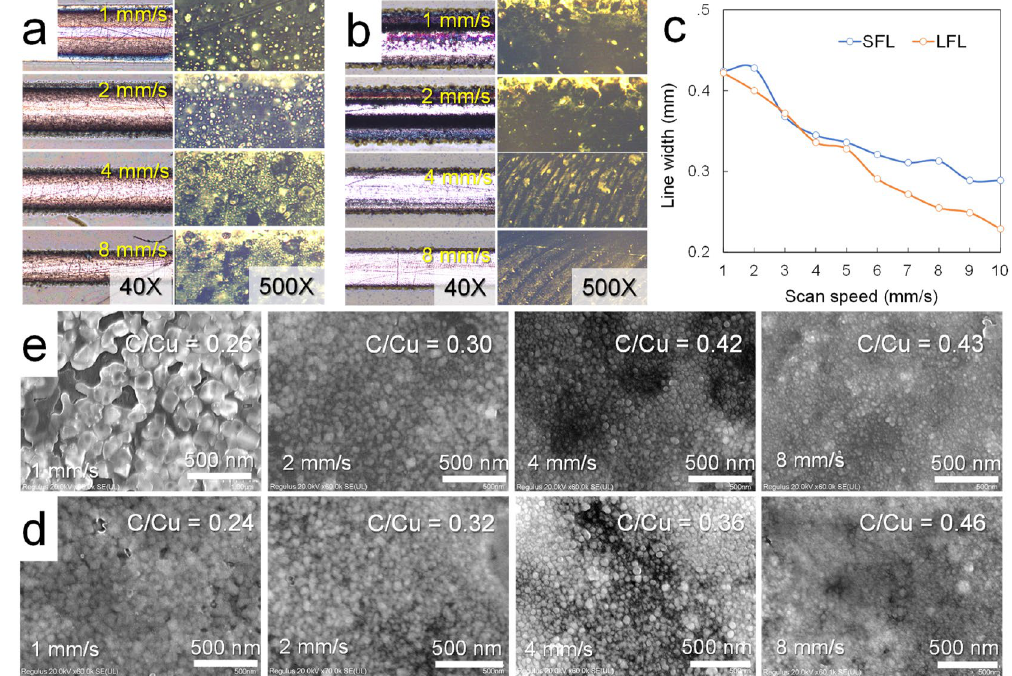
Figure 5. Microscope and scanning electron microscope (SEM) images of patterned Cu as a function of laser scan speed from 1 to 8 mm/s at 38% PWM input: ( a ) Cu lines formed at LFL, ( b ) Cu lines formed at SFL, ( c ) line widths of Cu patterns against the scan speed, ( d ) SEM images of LFL, and ( e ) SEM images of SFL against the scan speed. The insets in ( a ) and ( b ) are enlarged images of each Cu